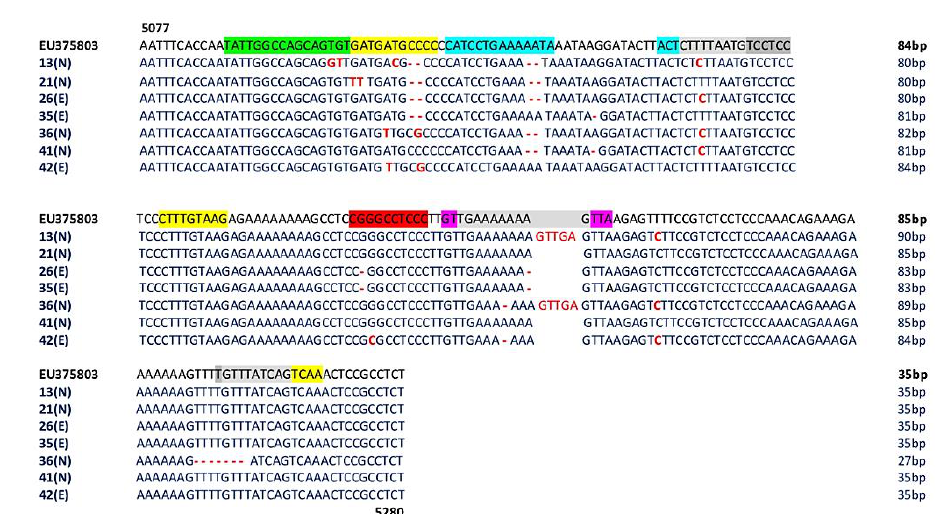
Table 2. Detection and quantification of Merkel cell polyomavirus (MCPyV) DNA by real-time qPCR. HIV-1 Status Patients, n. MCPyV+ Patients, n.